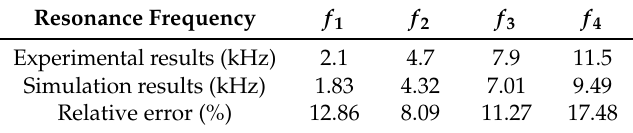
Table 3. Comparison of experimental and simulation results.